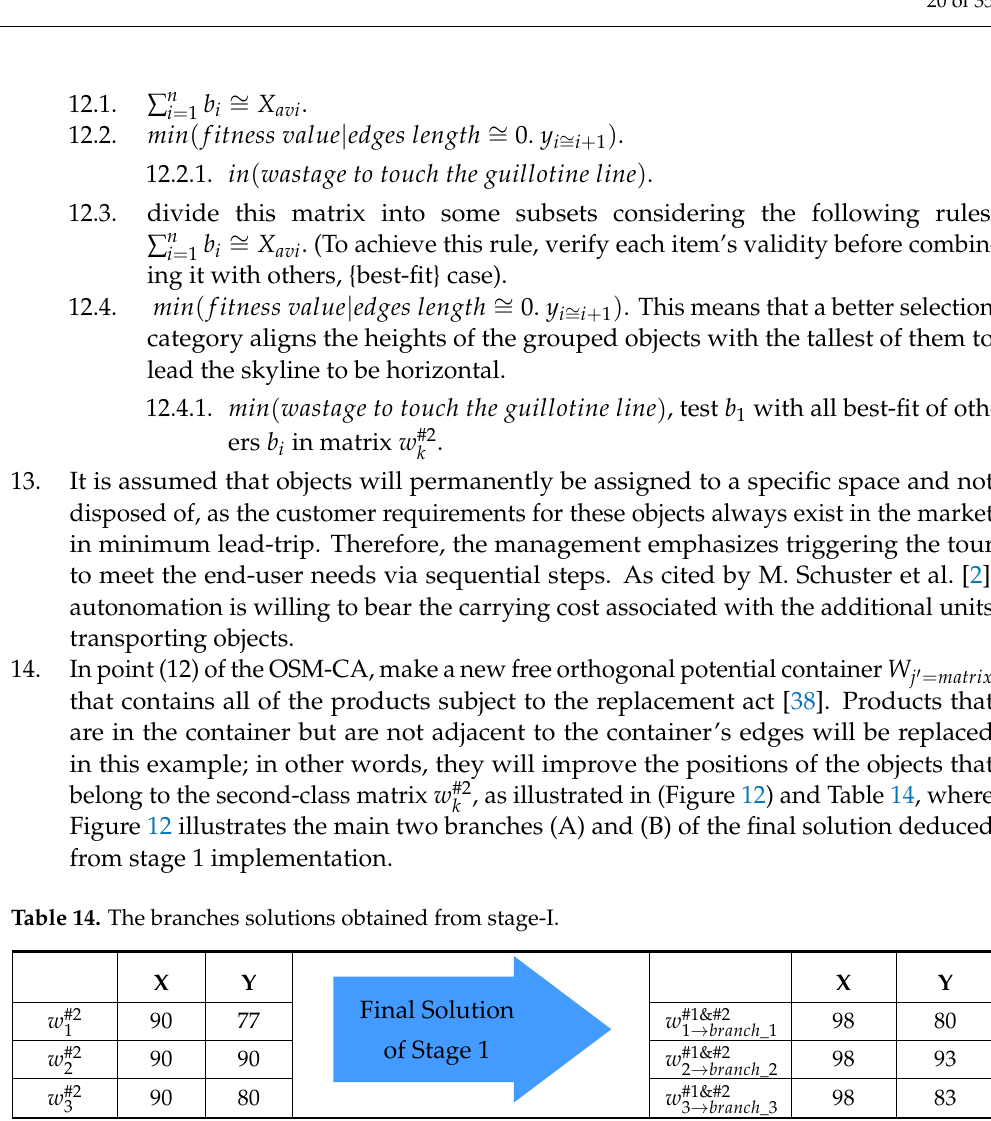
Table 14. The branches solutions obtained from stage-I.